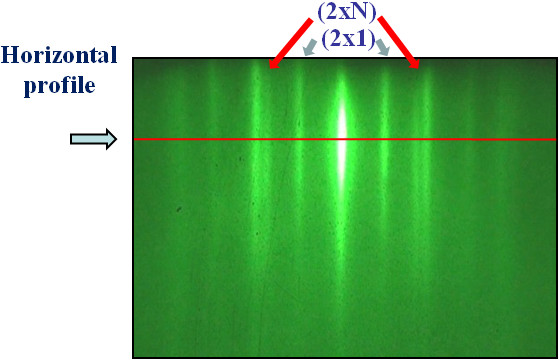
The horizontal profile of the RHEED pattern for GexSi1−x layer (x= 0.2).